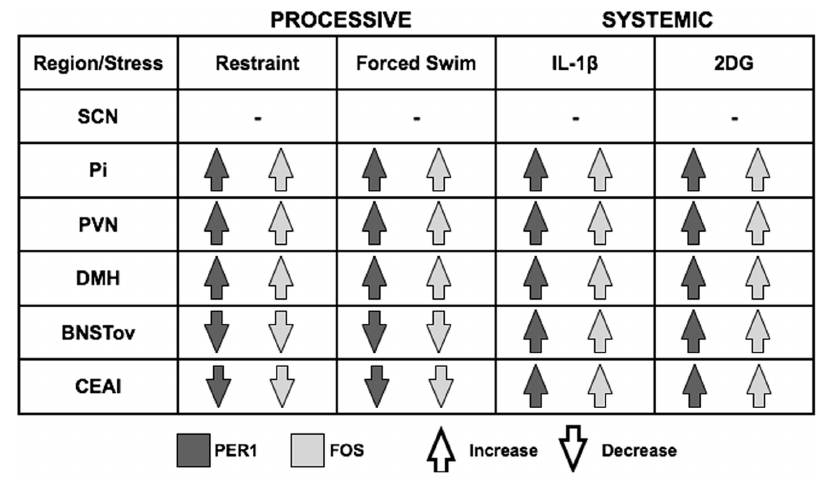
Figure 7. Summary of the effect of acute exposure to categorically-different stressors on PER1 and FOS expression. Note the distinct effects of processive versus systemic stress on PER1 and FOS expression in in the BNSTov and CEAl.